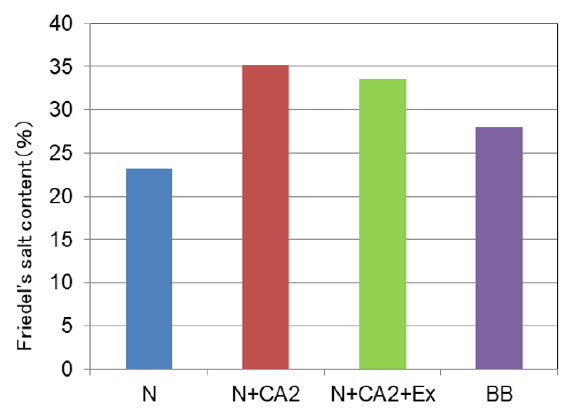
Figure 8. Friedel’s salt content.